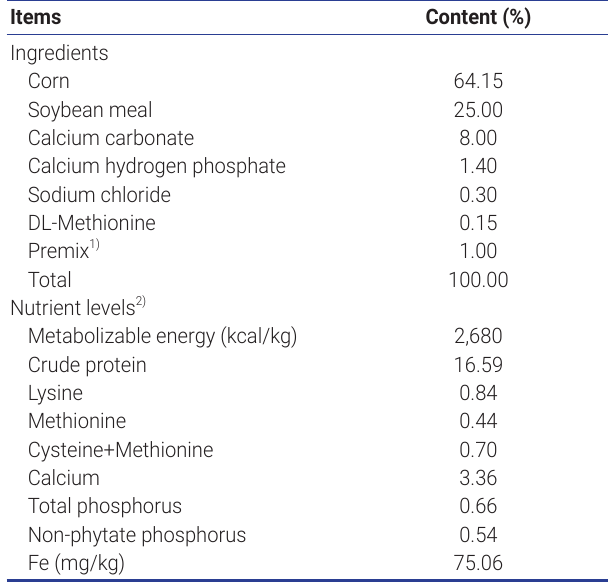
Table 1. Ingredient composition and nutrient levels of the basal diet for the hens (air-dry